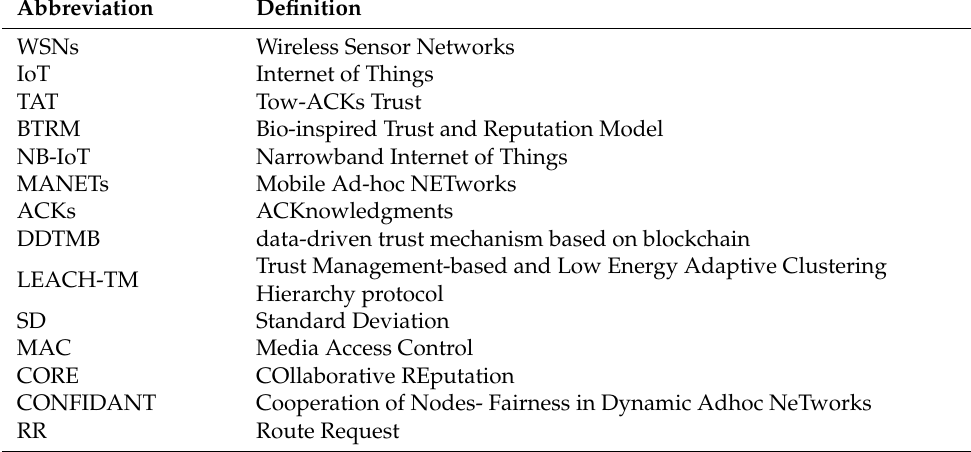
Table 1. List of